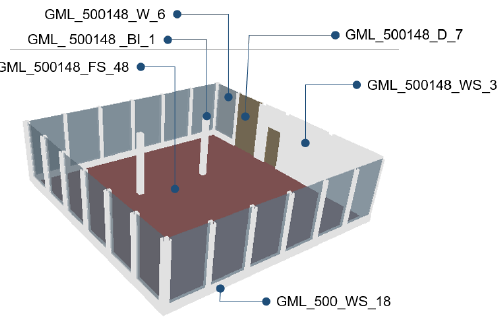
Figure 9. Agricultural Sciences Building’s Cafeteria: CityGML LOD4 model